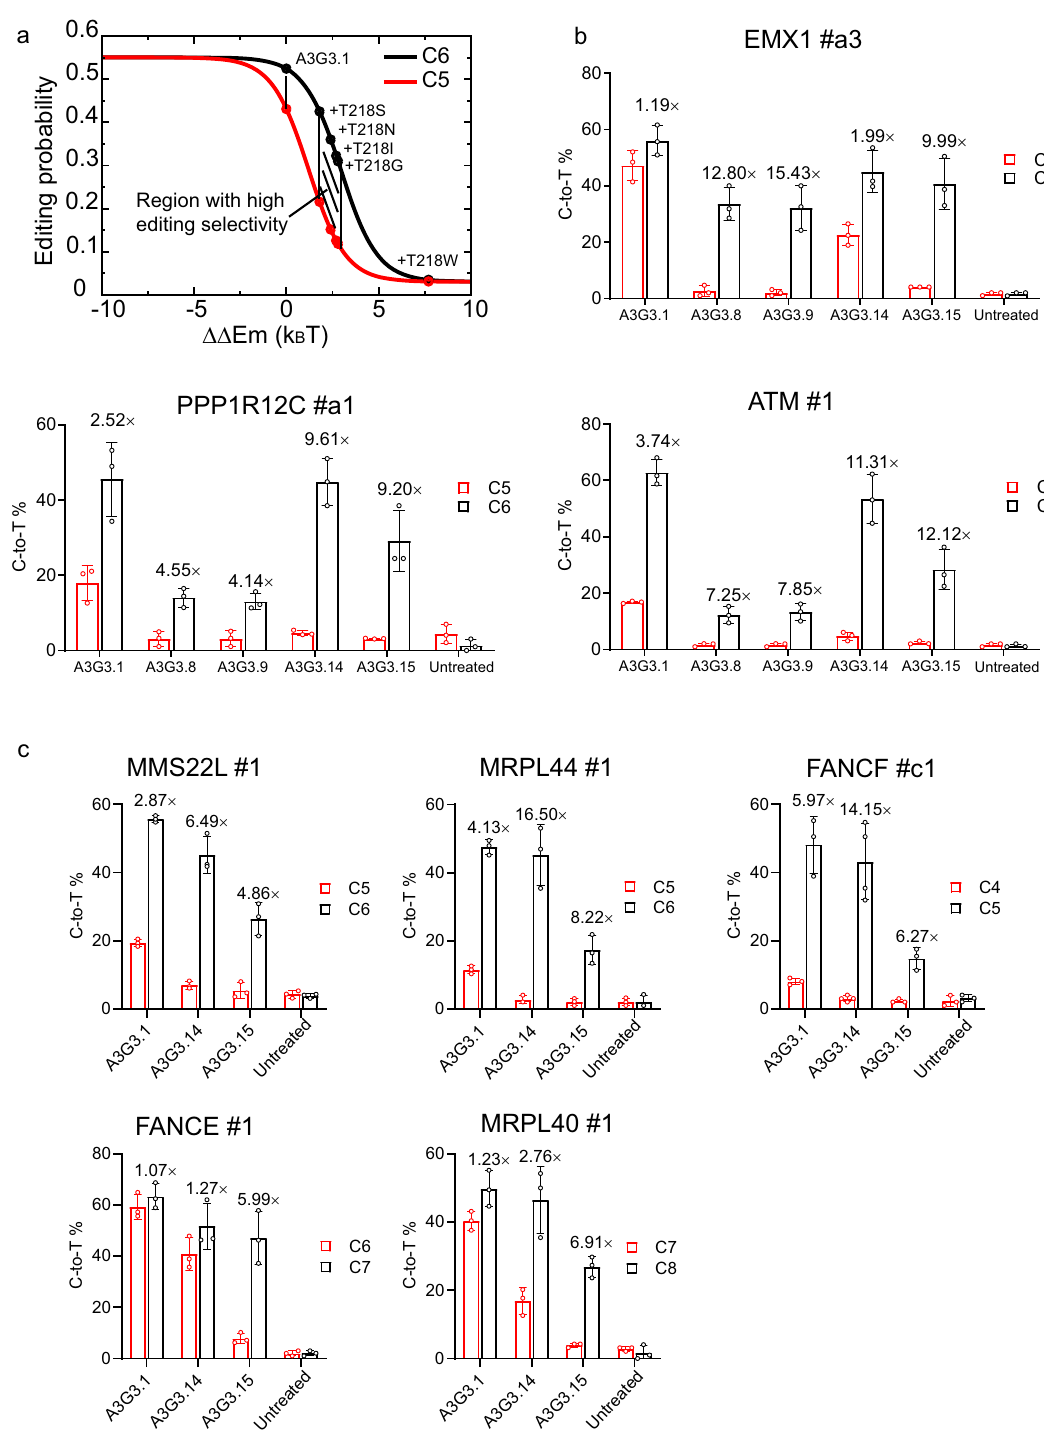
Fig. 4 Engineering of A3G-BEs. a Theoretical calculation. C6 represents the target base. C5 represents the bystander. The shaded area represents the region with improved editing selectivity. b Experimental measurements at three genomic loci for four mutations picked by theoretical model; A3G3.1 is the full-length APOBEC3G deaminase with a set of mutations which increase the catalytic ef fi ciency. A3G3.8, 3.9, 3.14, and 3.15 are A3G3.1 with T218G, T218I, T218S, and T218N, respectively. Bar plots represent the mean ± s.d. of three independent biological replicates. c Experimental measurements at other fi ve genomic loci for A3G3.14 (T218N) and A3G3.15 (T218S). Bar plots represent the mean ± s.d. of three independent biological replicates, except for the bar representing the editing ef fi ciency of A3G3.14 at FANCF #c1 site, which shown the mean ± s.d. from four biological replicates. Source data are provided as a Source Data fi